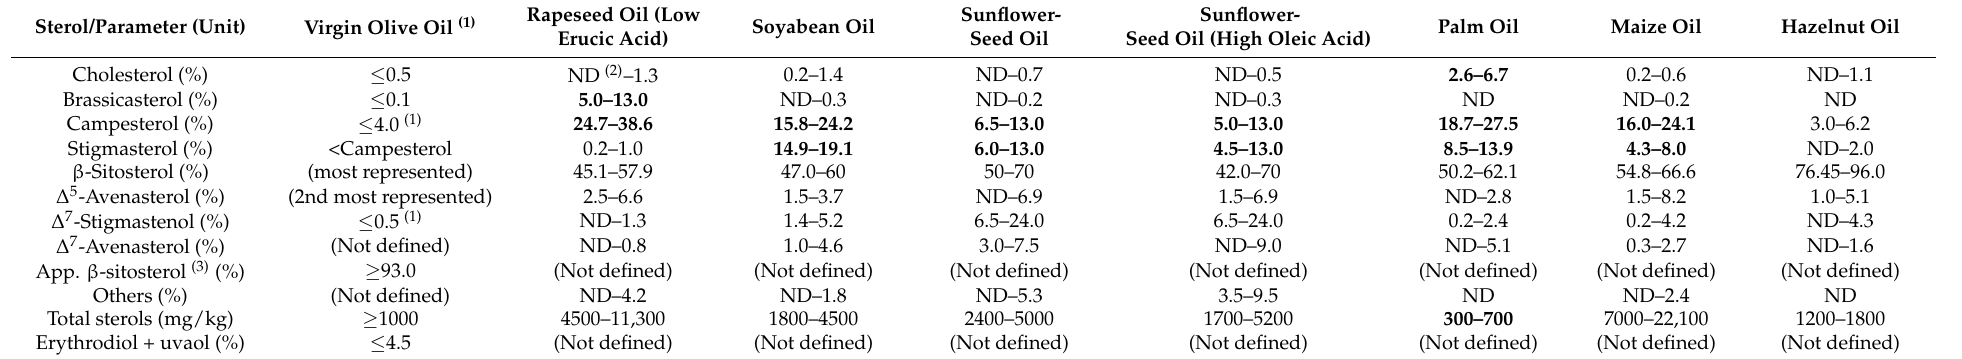
Table 1. Levels of sterols in olive oil (International Olive Council Trade Standard [49], Commission Regulation 2568/91 [10], limits are obligatory for verifying authenticity) and crude vegetable oils (Codex Alimentarius Standard for named vegetable oils [50], Appendix (limits are for voluntary application)). Ranges/limits highlighted in bold indicate specificities of oils from other plant species with respect to olive